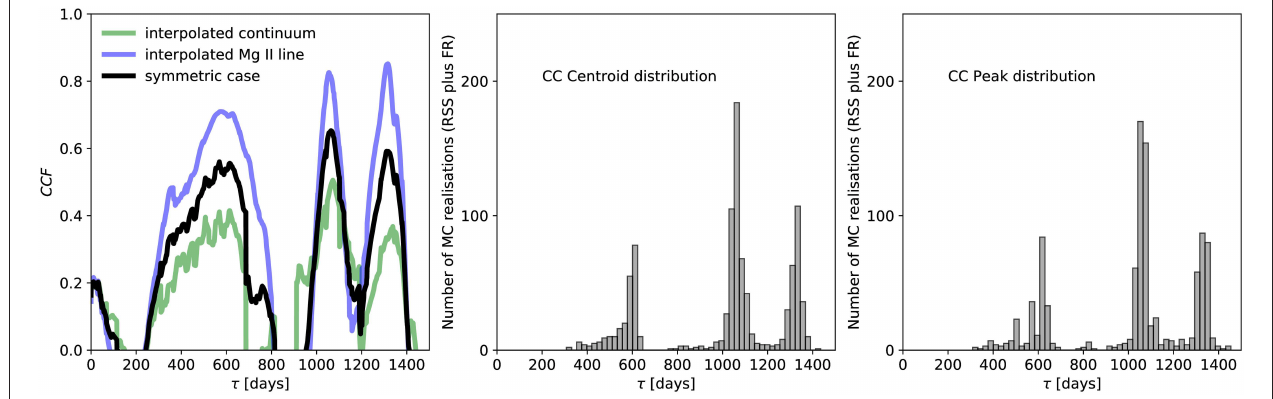
FIGURE 2 | Results of the interpolated cross-correlation analysis between the continuum and MgII line emission. (Left) The CCF value as a function of the time-delay for the continuum light curve interpolated to the emission-line light curve (green line), for the emission-line light curve interpolated to the continuum light curve (blue line), and the symmetric interpolation (black line). (Middle) Cross-correlation centroid distribution. (Right) Cross-correlation peak distribution.